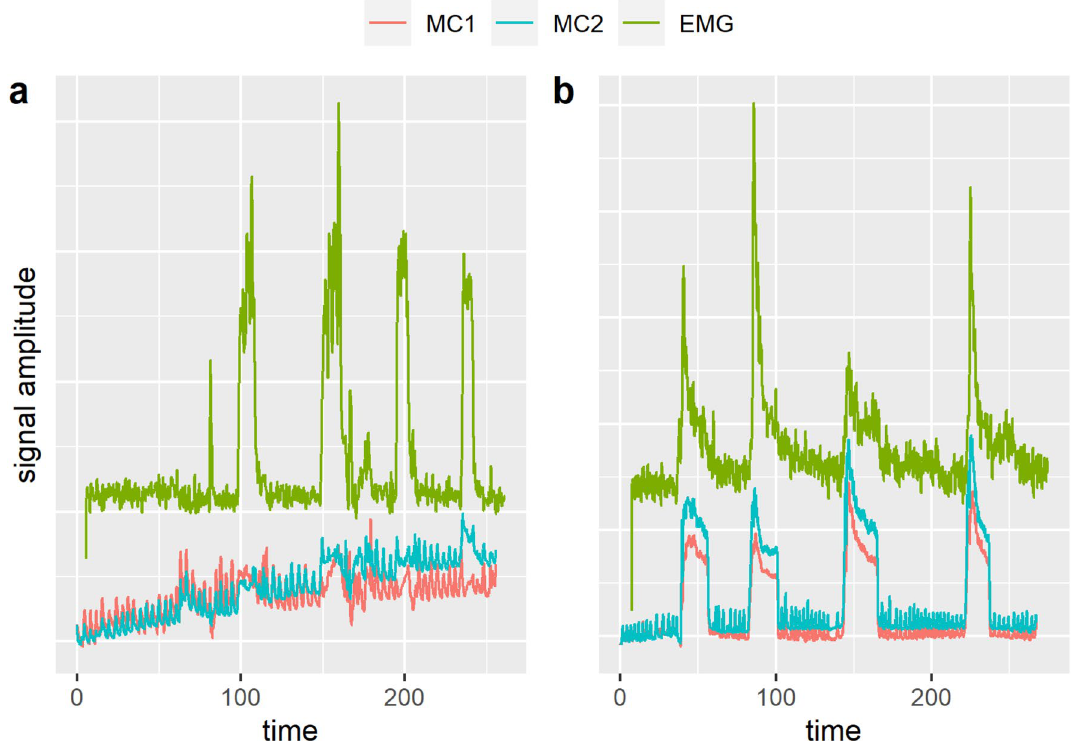
Figure 5. Exemplary recordings of EMG and MC signals from two patients. ( a ) Patient without rise in IAP - unsuccessful VM. ( b ) Patient with rise in IAP - successful VM. On the left, it is clear from the EMG that the patient was activating the musculature, but the MC signals only show a disturbance in the respiratory oscillations without a significant and/or sustained change in the mean MC signal. Note: The continuously rising MC signal seen in figure 5a was also observed in some of the patients who have managed to raise their IAP, where it was most pronounced during the rest phases. We believe this to be a physical artifact of the sensor, possibly related to a too short waiting period before the measurement, as the residual skin viscoelasticity after attachment of the sensors could be causing the